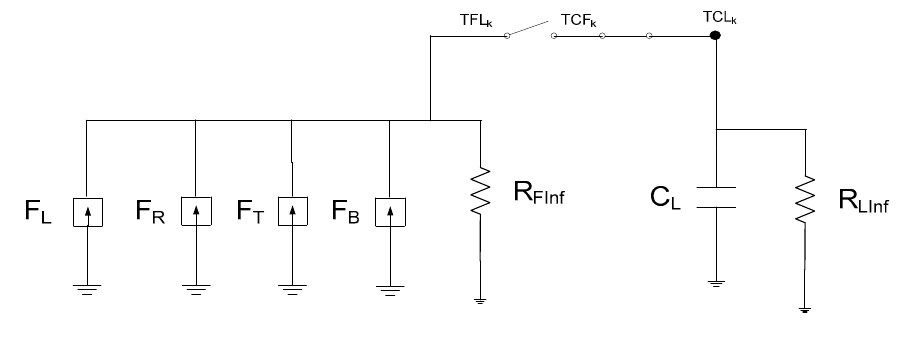
Figure 5. Network model of the solidification equation.